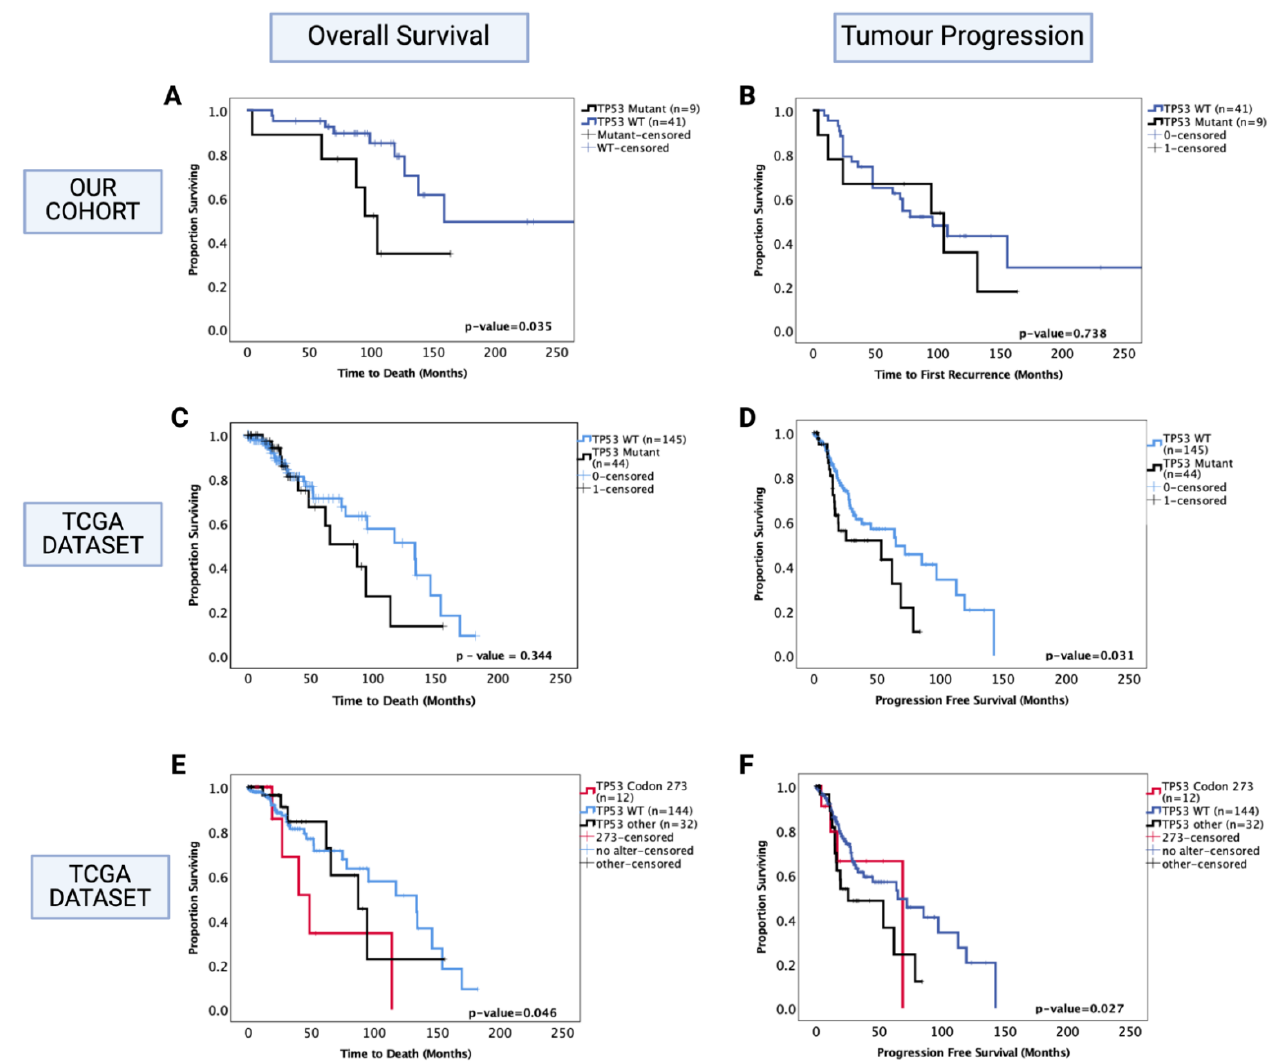
Figure 4. Kaplan–Meier survival curves for oligodendroglioma based on TP53 mutation status. ( A ) Overall survival and ( B ) progression-free survival stratified by TP53 wild-type and TP53 mutant cases in our dataset. ( C ) Overall survival and ( D ) progression-free survival curves for the TCGA oligodendroglioma dataset, stratified by TP53 wild-type and TP53 mutant cases. ( E ) Overall survival and ( F ) progression-free survival curves for the TCGA oligodendroglioma dataset, stratified by TP53 wild-type, TP53 codon 273 mutant, and other TP53 mutant cases. TP53 273: TP53 codon 273 mutant, TP53 OTHER: all pathogenic TP53 mutations except in codon 273, TP53 WT: wild-type TP53 status. Log-rank test was used for analysis and a p -value < 0.05 for statistical significance .